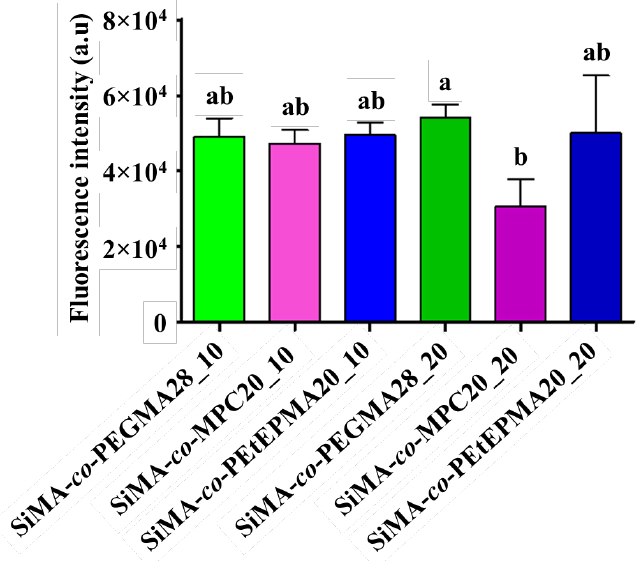
Figure 7. Intensity of fluorescence emitted by N. salinicola cells adherent to different surface samples, after 24 h of exposure. An ANOVA analysis (n = 3) followed by a Tukey post-hoc test were performed for multiple comparisons. Not-shared letters indicate statistically significant differences, p ≤ 0.05. Fluorescence intensity for was 5.38*10 4 ± 0.52*10 4 a.u. (mean ± standard deviation).